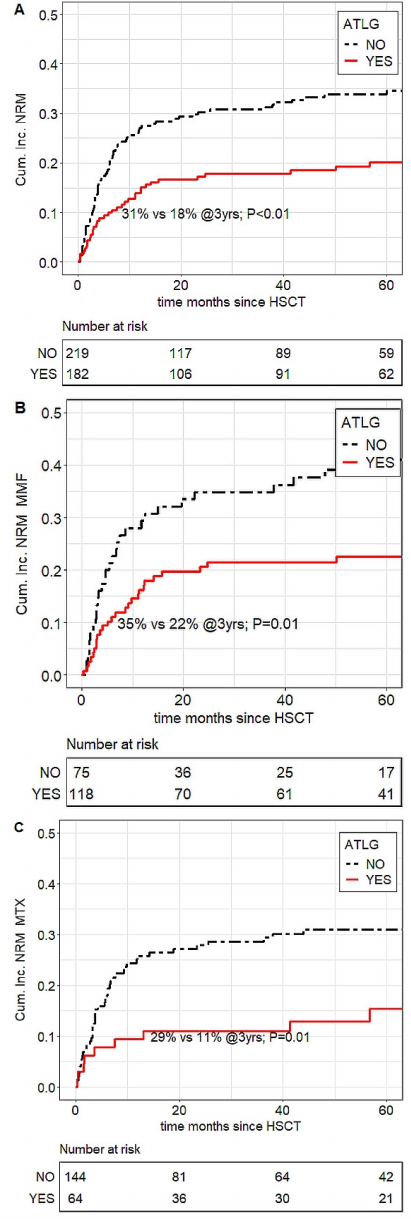
Figure 3. NRM by ATLG. Red line, ATLG; black line, no ATLG. ( A ) Entire cohort. ( B ) MMF-based HSCT. ( C ) MTX-based